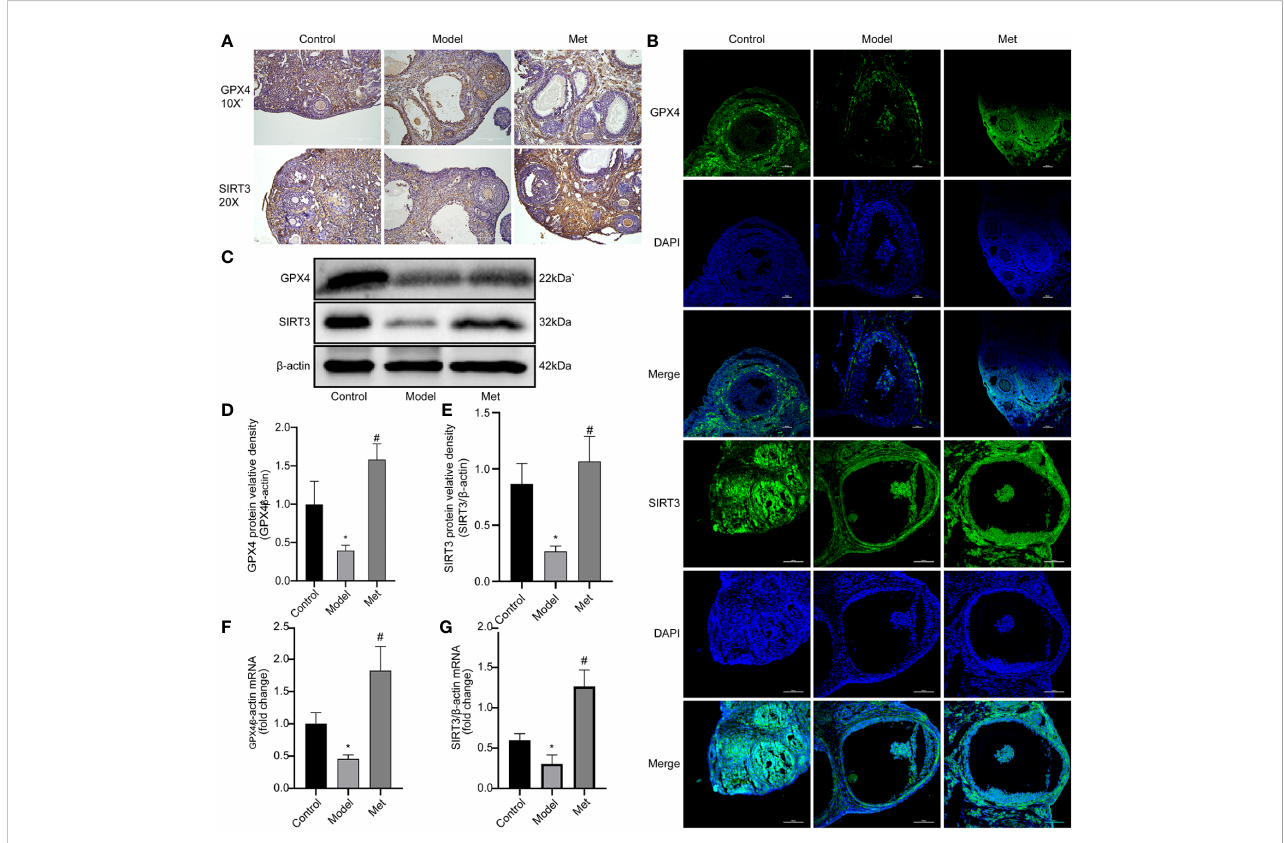
FIGURE 4 Metformin promotes the expression of GPX4 and SIRT3. (A) Immunohistochemistry of GPX4 and SIRT3 in mouse ovary; (B) Immuno fl uorescence of GPX4 and SIRT3 in mouse ovary; (C) WB of GPX4 and SIRT3 in mouse ovary; (D) Relative protein density of GPX4; (E) SIRT3 relative protein density. (F)